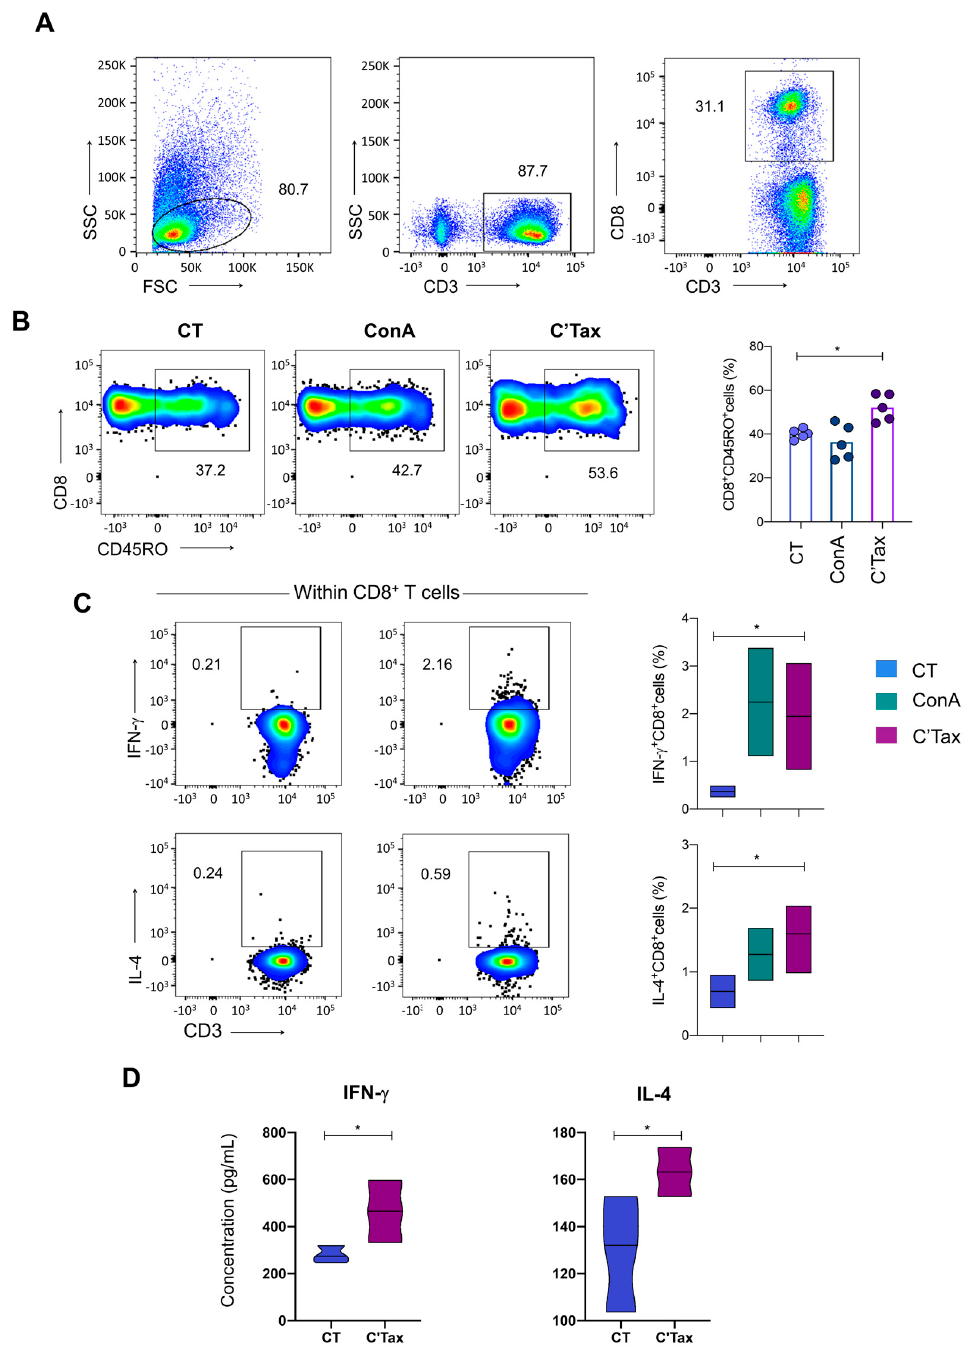
Figure 7. Activation of CD8 + T cells upon stimulation with recombinant C-terminal portion of Tax. ( A ) First, the selection of CD8 + T lymphocytes (CD3 + CD8 + ) within total lymphocytes was performed. ( B ) Second, the evaluation of antigen-experienced memory CD8 + T cells (CD3 + CD8 + CD45RO + ) after stimulation with C’Tax was carried out and the results are shown as pseudo color plots (left panels) and bar graphs overlaid by scatter plots (right panels). ( C ) After that, IFN- γ and IL-4 production by CD8 + T cells was examined and the results are expressed in the flow charts (left panels) and by floating bars (min–median–max values on the right panel). ( D ) Finally, the levels of IFN- γ and IL-4 in PBMC culture supernatants after stimulation with C’Tax were evaluated. The results are plotted as violin graphs. Statistical differences for all plots were indicated by connecting lines and asterisks when p < 0.05 (* indicates p ≤ 0.05).